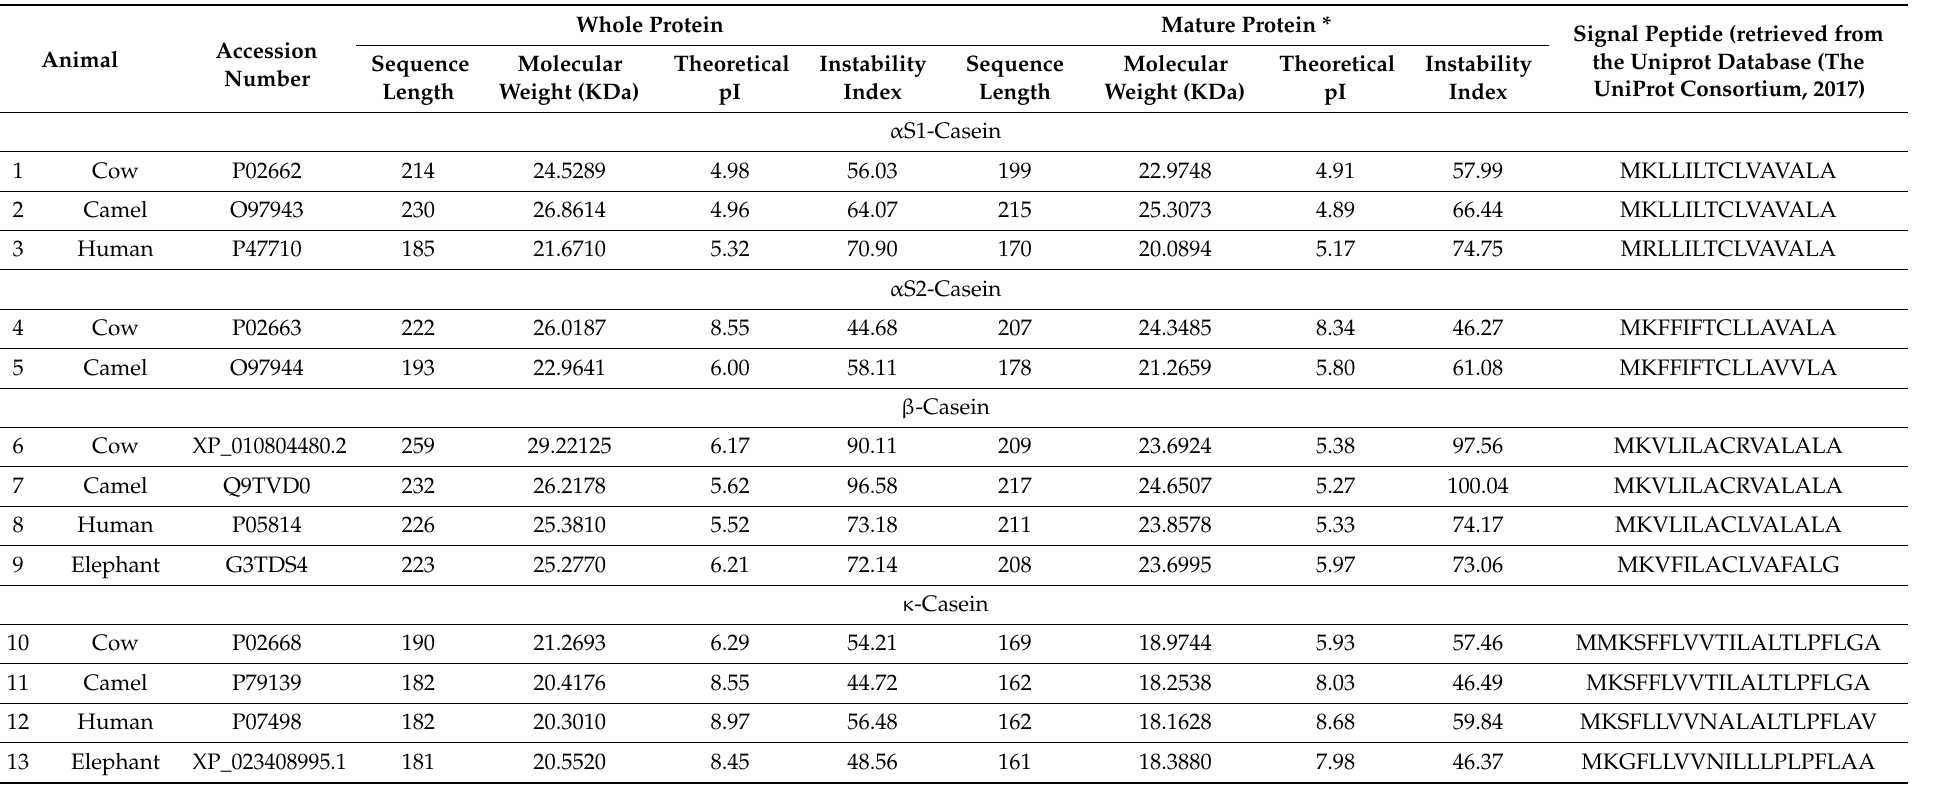
Table 3. Key physicochemical parameters showing the diversity in isoelectric points (pI) and stability scores of the different caseins as estimated from the